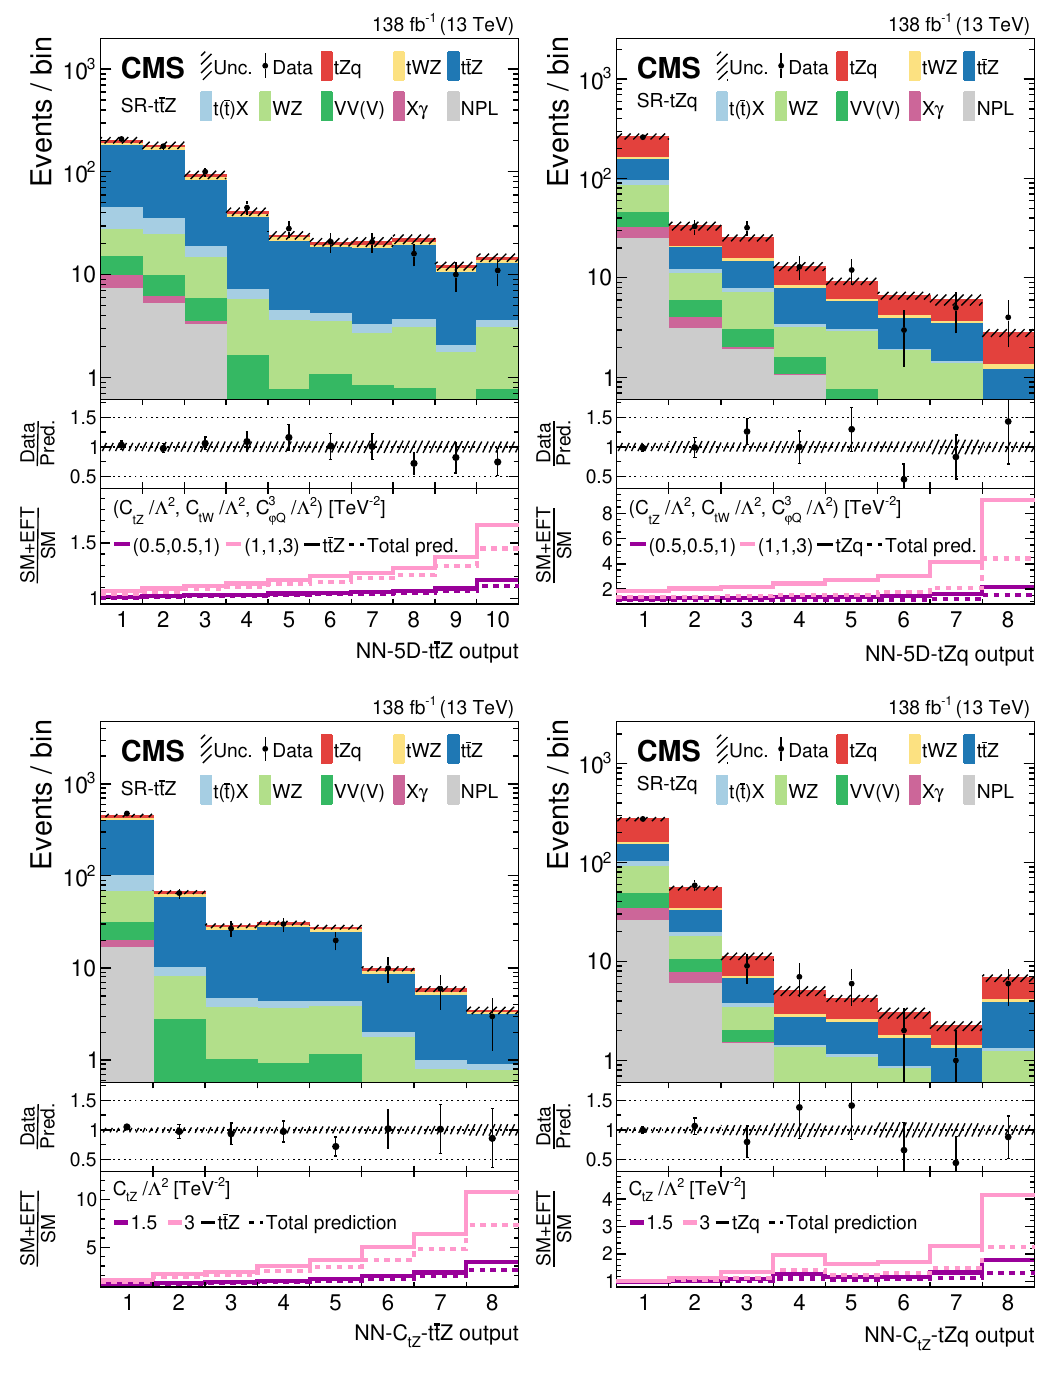
Figure 5 . Post-fit data-to-simulation comparisons for the distributions used in the SR- ttZ (left) and SR- tZq (right), for the 5D fit (upper) and for the 1D fit to c display the ratios of the observed event yields to their post-fit expected values. For each region, the lower panel shows the change of the event yield in each bin with respect to the SM post-fit expectation for two benchmark EFT scenarios, both for the main signal process in the region (thick lines) and for the total prediction (dashed